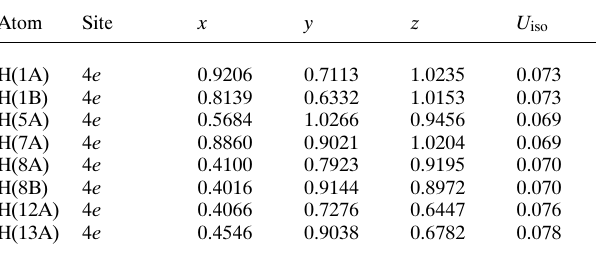
Table 2. Atomic coordinates and displacement parameters (in Å 2 )